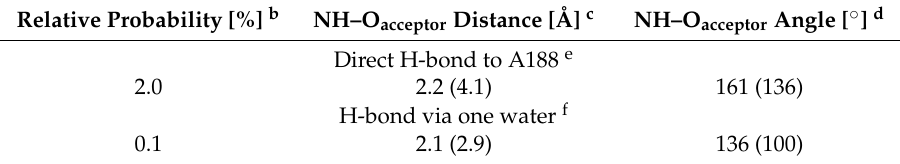
Table 1. Probabilities to form the key mechanistic hydrogen bond to the reacting NH-group of the amide substrate in the modeled transition state (TS).